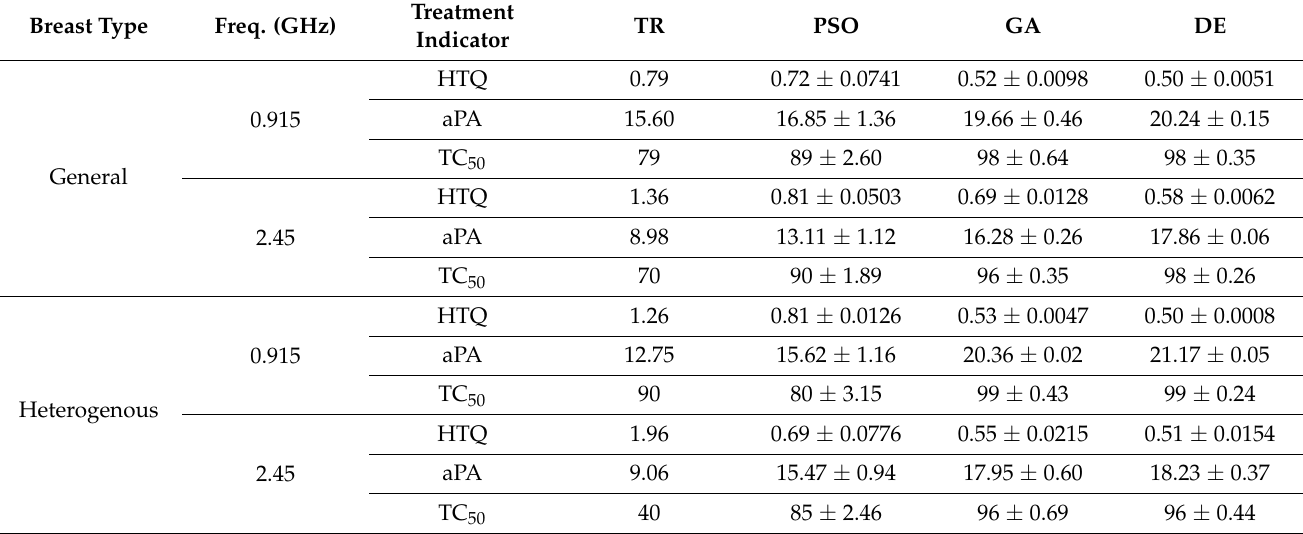
Table 2. Mean and standard deviation of treatment indicators of two breast models optimized using four HTP optimization